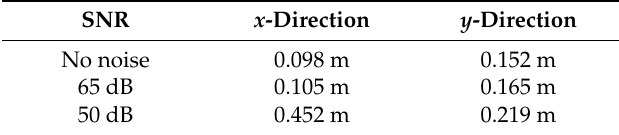
Table 2. Standard deviation of the landmarks’ positions in x - and y